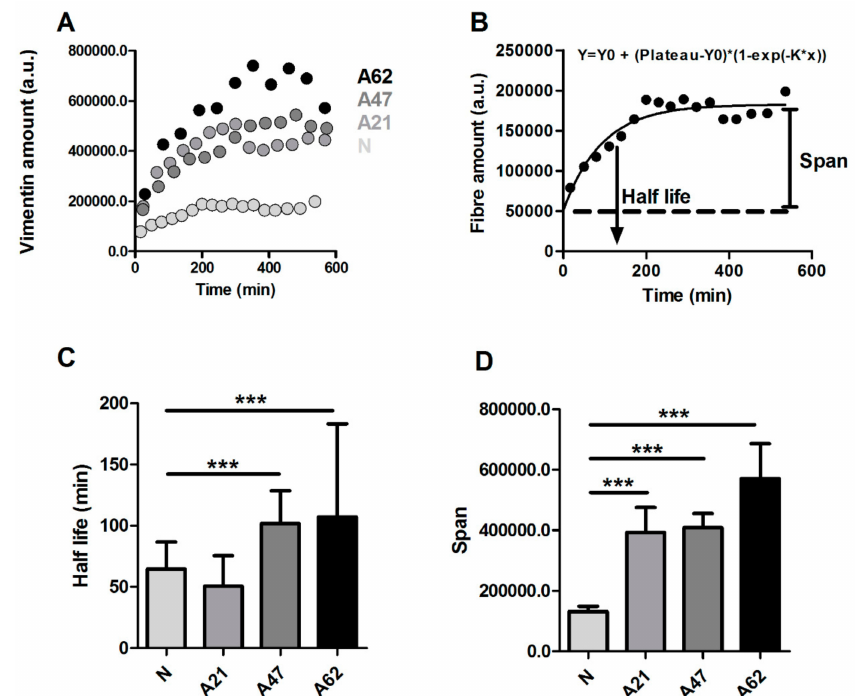
Figure 4. Vimentin fibre remodeling rate is faster in cells from young donor. ( A ) Representative plot shows the temporal changes in vimentin fibre intensity during reattachment time of cells from di ff erent donor ages. ( B ) An exponential model was used to fit the data and to determine parameters such as half-life and span. ( C ) There was a statistically significant di ff erence in vimentin fibre remodeling half-life, indicating slower vimenitin remodelling rate for adult cells. ( D ) The span indicates that the vimentin fibre amount is higher in adult cells. Data are plotted from at least three independent experiments and presented as mean values with SD (*** p < 0.001, obtained using Dunnett test against neonatal donor). Cell number varies between